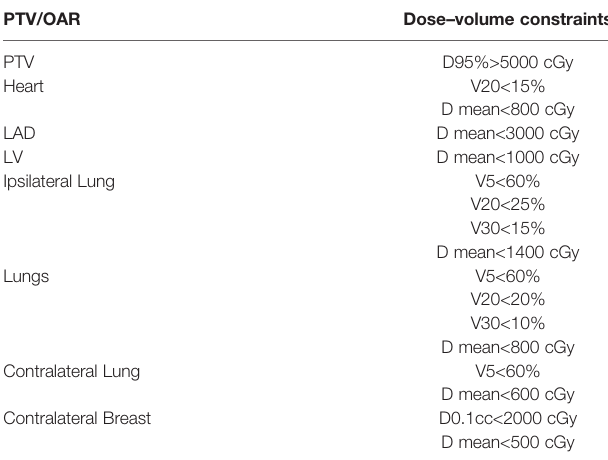
TABLE 2 | The dose-volume constraints on TPS optimization interface for planning target volume and organs at